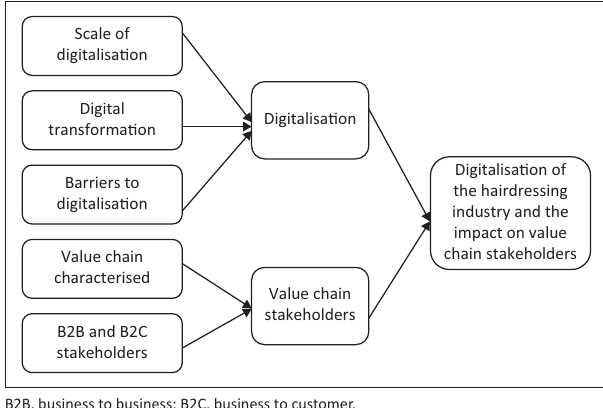
FIGURE 1: Conceptual framework for the digitalisation of the hairdressing industry and the impact on value chain stakeholders.